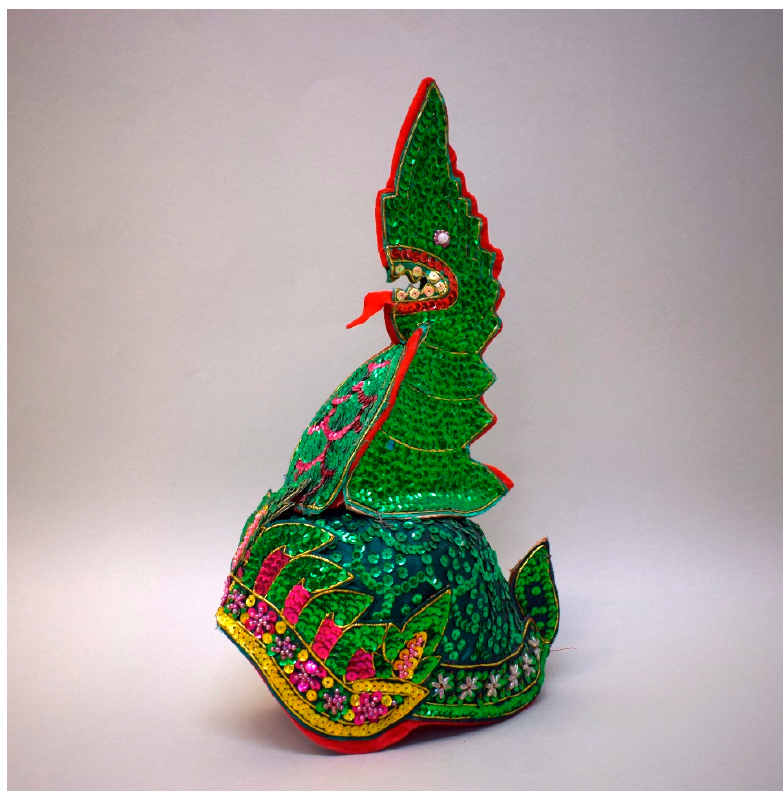
Figure 6. Helmet used for the ordination of Burmese novices (purchased for the Marburg Museum of Religions in 2012 by Ulrike Jeep, photo by Heike Luu, acc.nr. Mq 152).